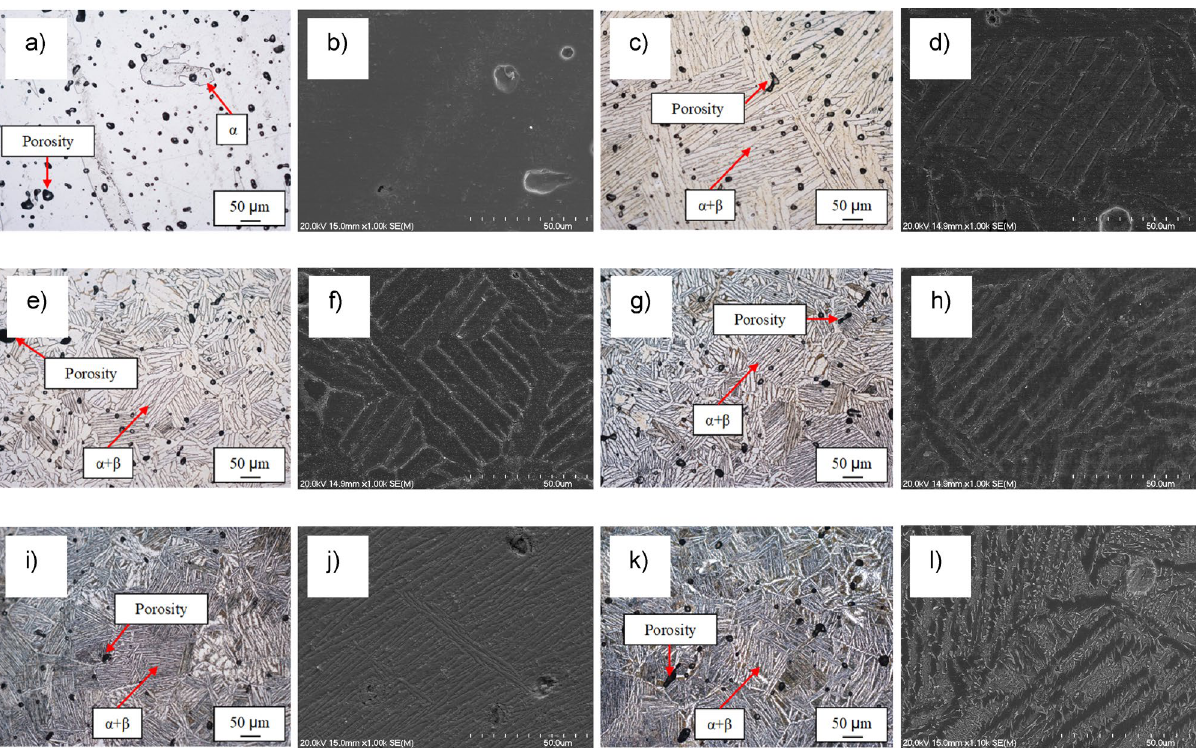
Figure 1. Optical and SEM micrographs, respectively, for: ( a ) and ( b ) CP Ti, ( c ) and ( d ) Ti–0.5Cu–0.5Mn, ( e ) and ( f ) Ti–1Cu–1Mn, ( g ) and ( h ) Ti–2Cu–2Mn, ( i ) and ( j ) Ti–3.5Cu–3.5Mn, and ( k ) and ( l ) Ti–5Cu–5Mn β eutectoid bearing functionalised Ti